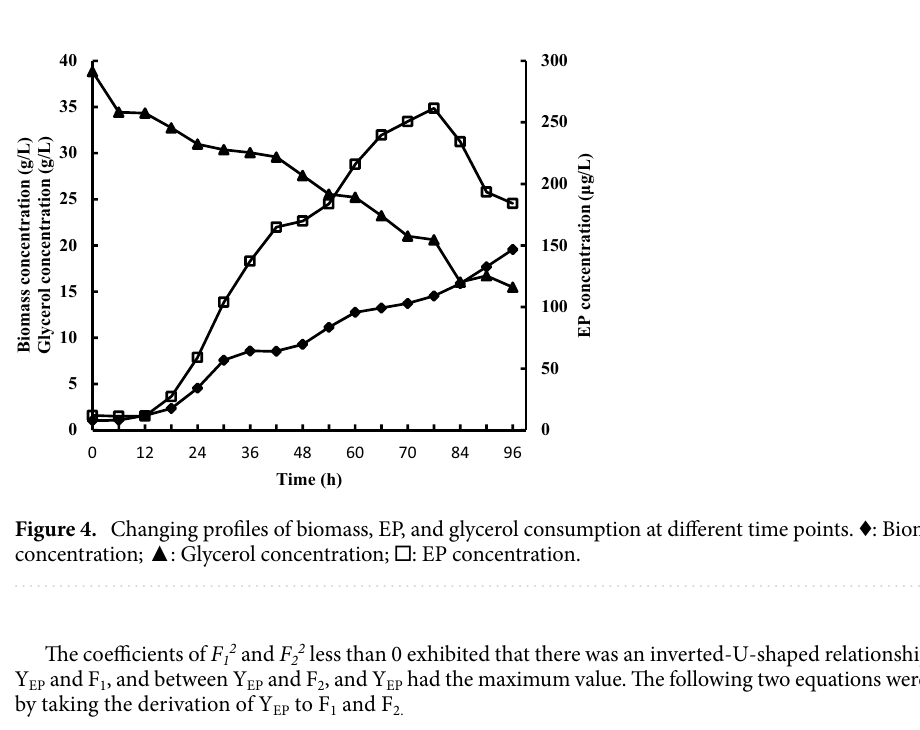
Table 2. The coefficient of each item and ANOVA results of regression equations with different factors and EP yields. Model: F = 7.454, p = 0.000.